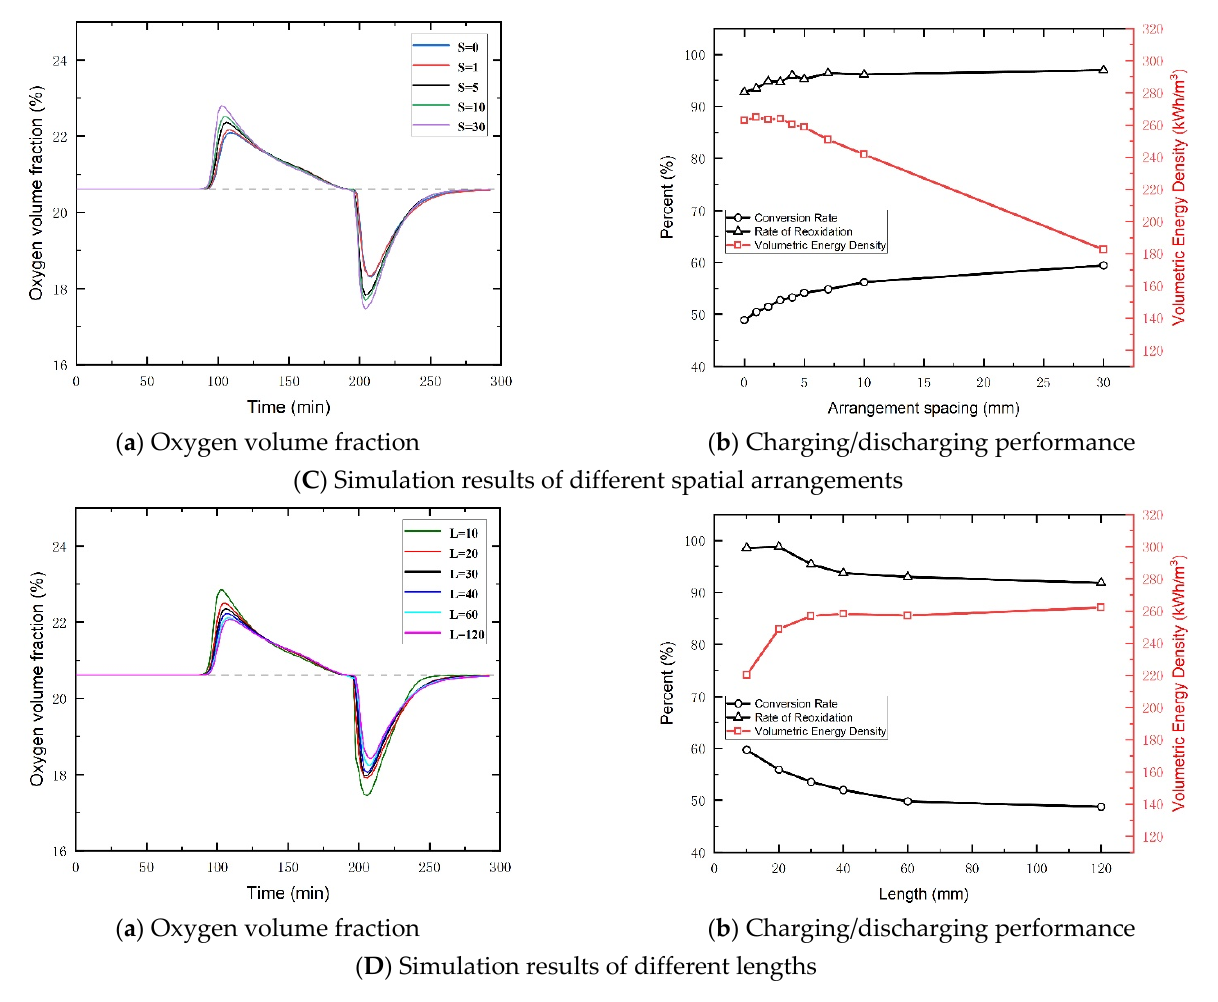
Figure 6. Simulation results in di ff erent scenarios.